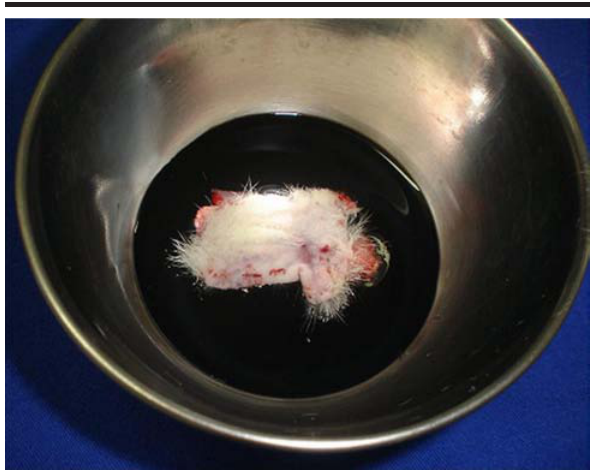
FIGURE 4 - Indian blue dying of peritoneal face of the resected abdominal wall fragment, including adhesions